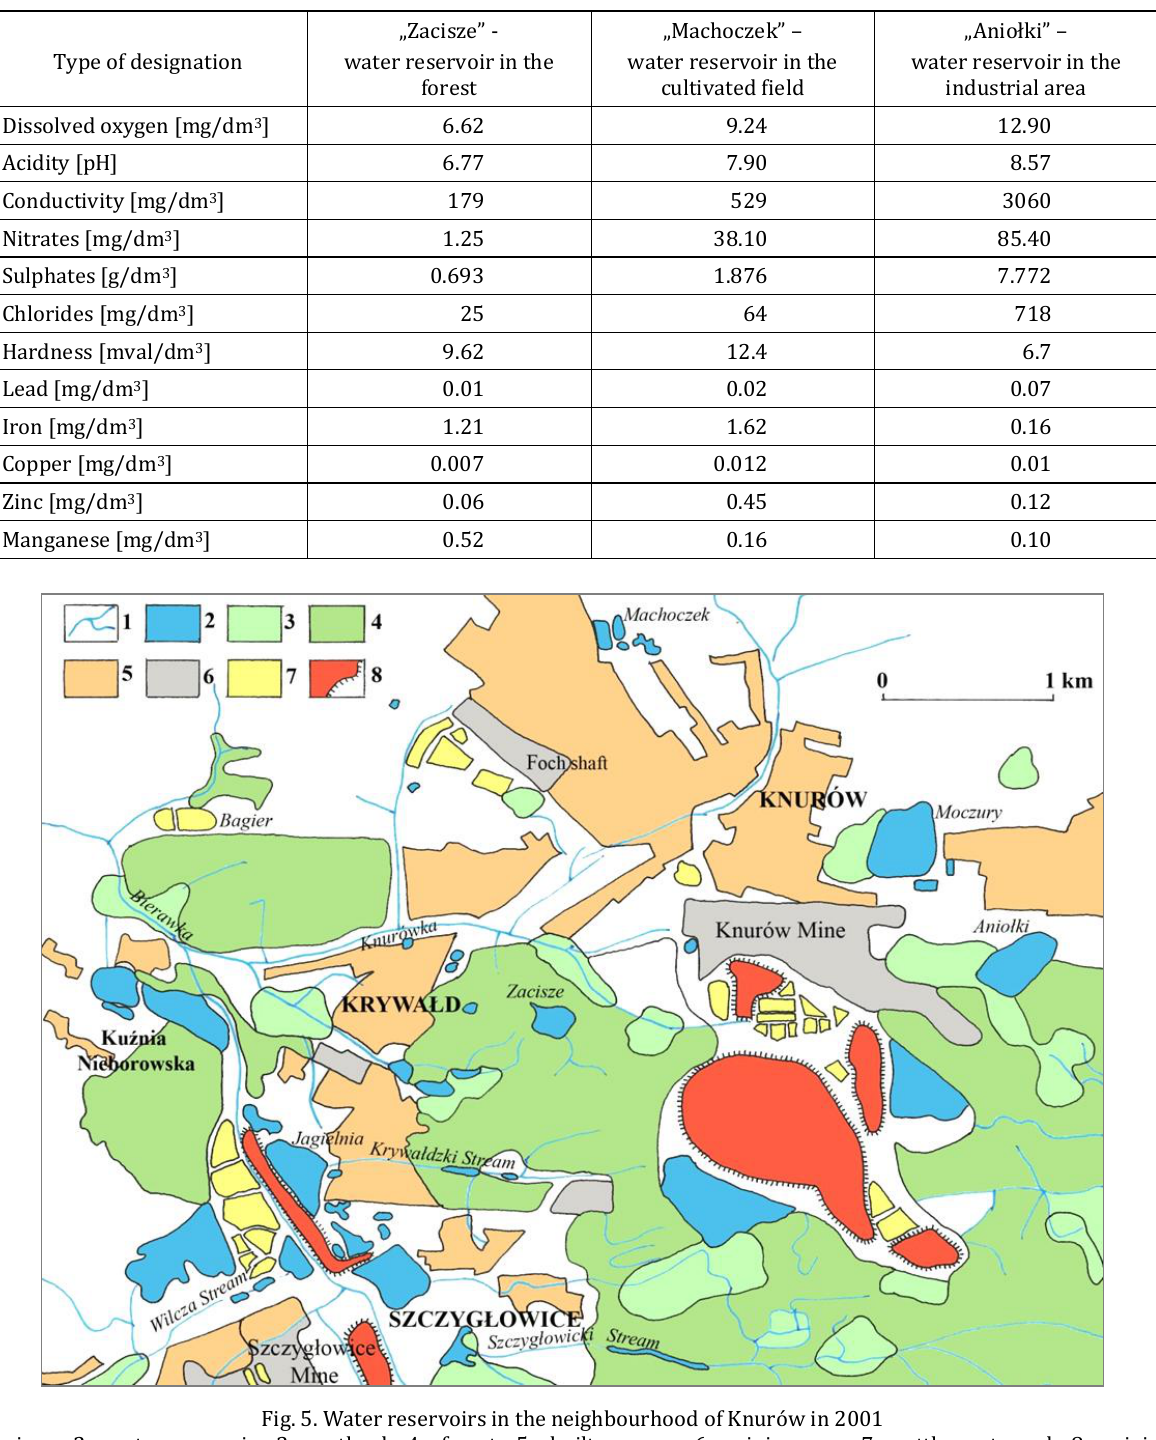
Table 2. Chemistry and heavy metals in the waters of selected water reservoirs in the neighbourhood of Knurów (after Salwa, 1995)